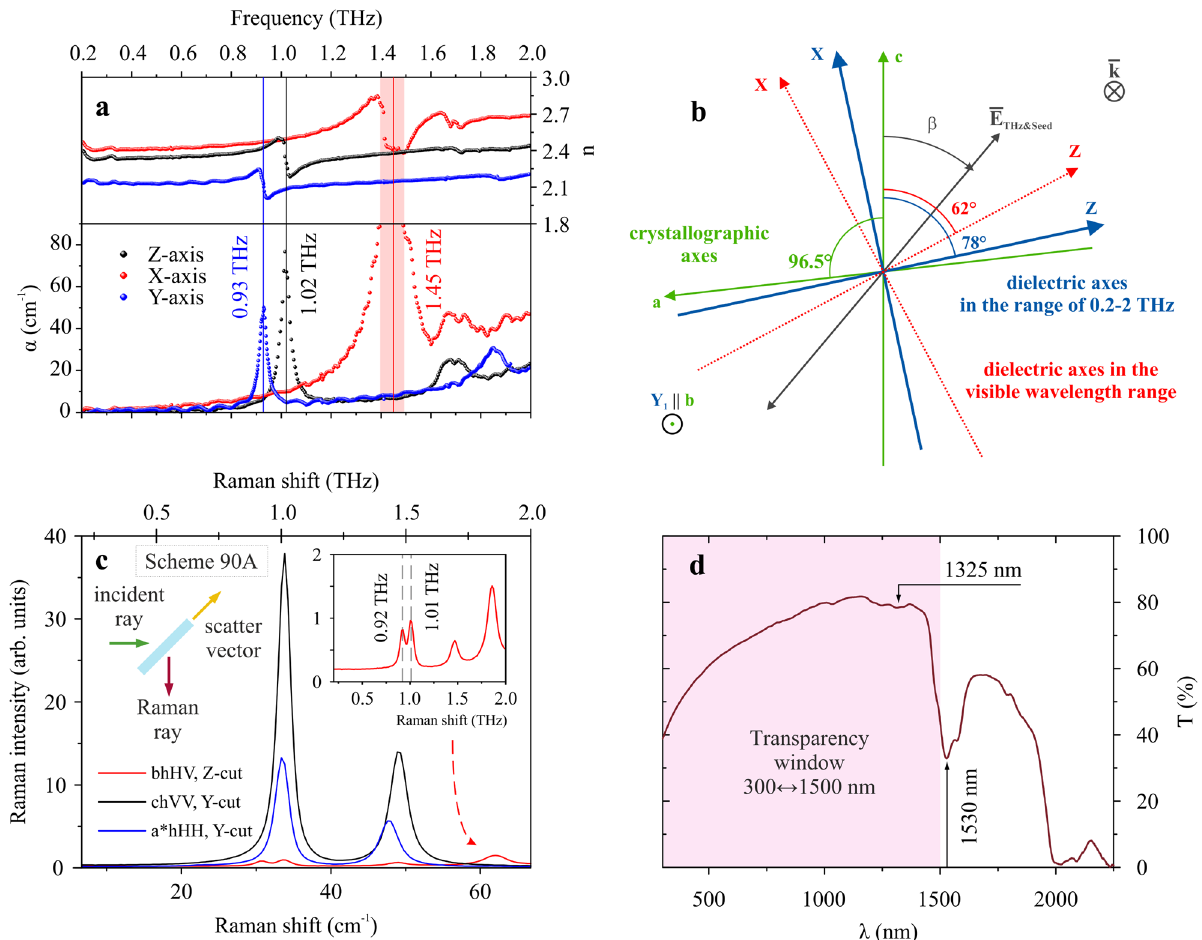
Figure 1. ( a ) Spectra of the refraction and absorption coefficients of GUHP crystal along three principal dielectric axes. The absorption coefficient is presented in terms of field. ( b ) Orientation of the crystallographic and dielectric axes in the Y-cut plane of GUHP crystal. The crystallographic axes are shown in green, the dielectric axes in the visible range are in red, and in the THz range in blue. ( c ) Raman spectra of GUHP crystal for three polarization-axis orientations at 293 K. The angle between the crystallographic axes a and c is 96.5 ◦ , so the blue curve corresponds to an orientation orthogonal to the c axis, close to a. The right inset shows an enlarged spectrum of the cross-polarized analyzer and polarizer regime. The left inset represents a schematic diagram of the experiment. ( d ) Transmission spectrum of GUHP crystal in the VIS-NIR spectral